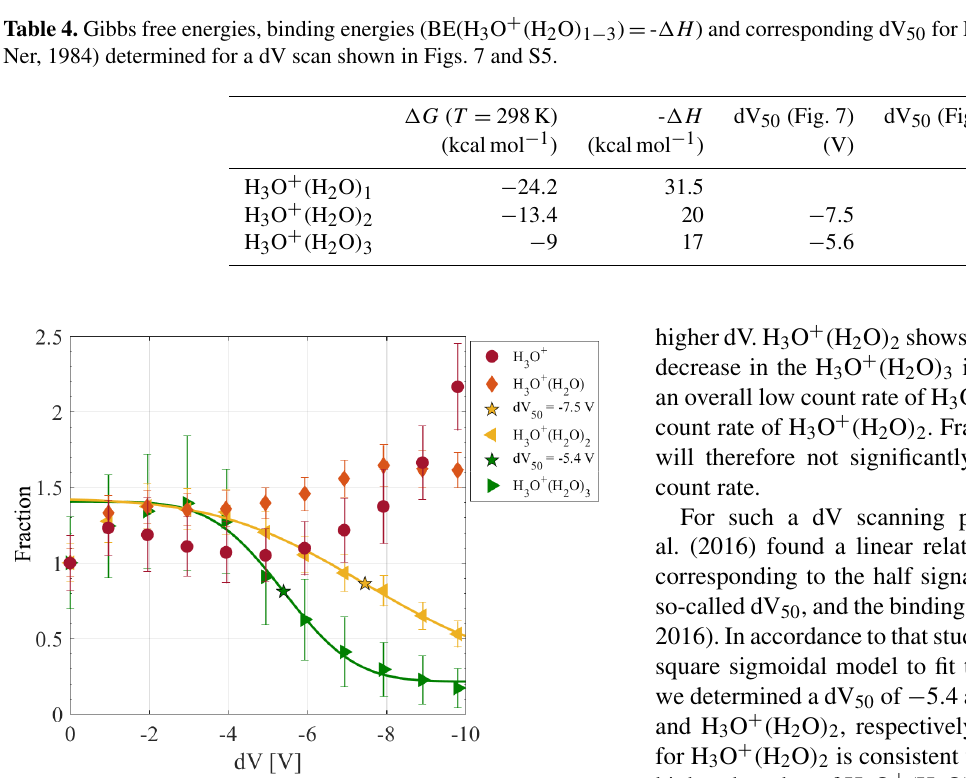
Figure 7. Declustering (dV) scan between the skimmer-1 and the second hexapole using hydrated hydronium clusters. Peak inten- sities are normalised on each ion’s initial signal. The dV 50 of H 3 O + ( H 2 O ) 3 is − 5 . 4V and that of H 3 O + ( H 2 O ) 2 is − 7 . 5V. The low-fragmenting setting uses a dV of − 1 . 4V, whereas − 10V is used for the high-fragmenting